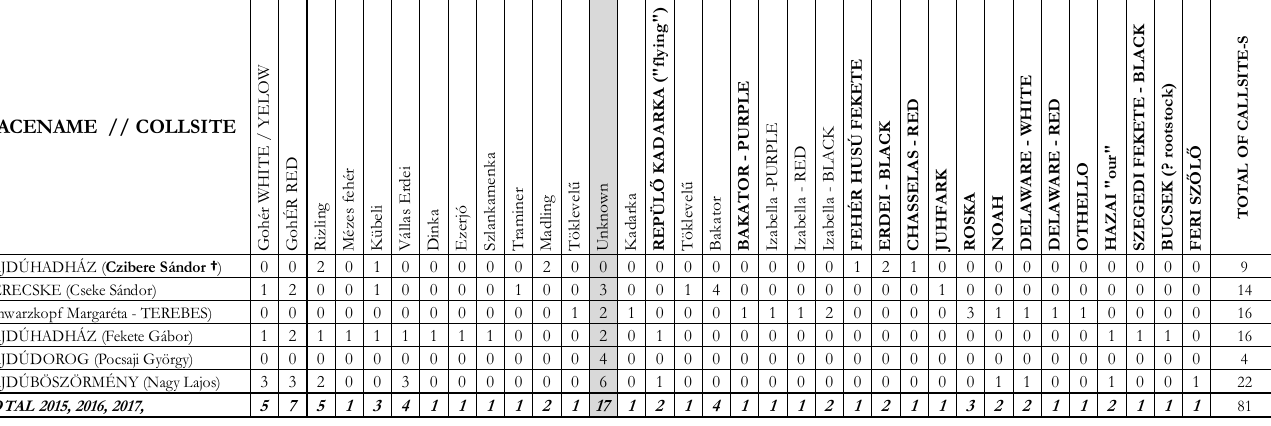
Table 4. OIV priority primary descriptors for ACENAME Gohér (WHITE)